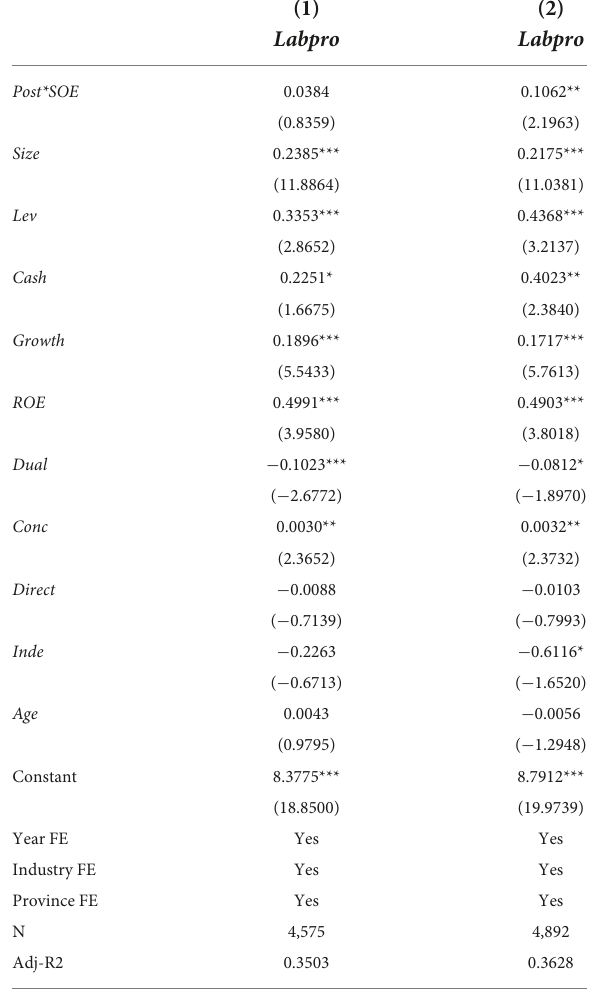
TABLE 8 Growth stage and maturation